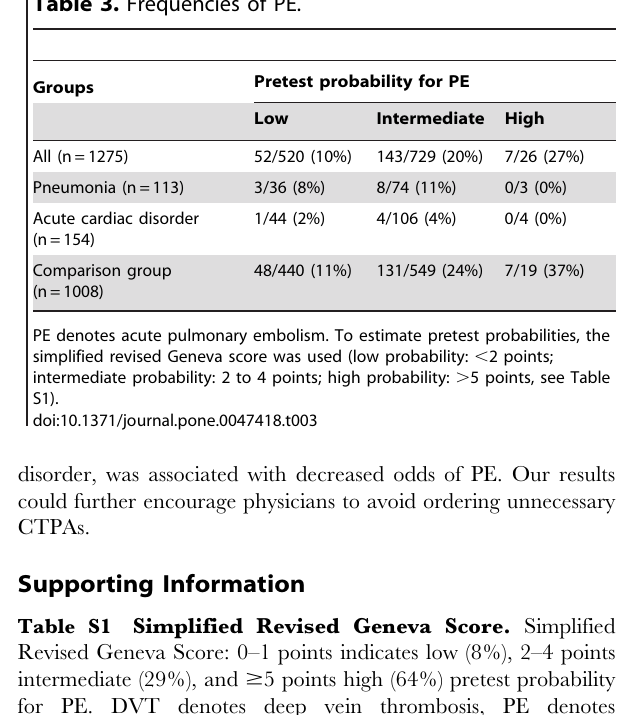
Table 3. Frequencies of